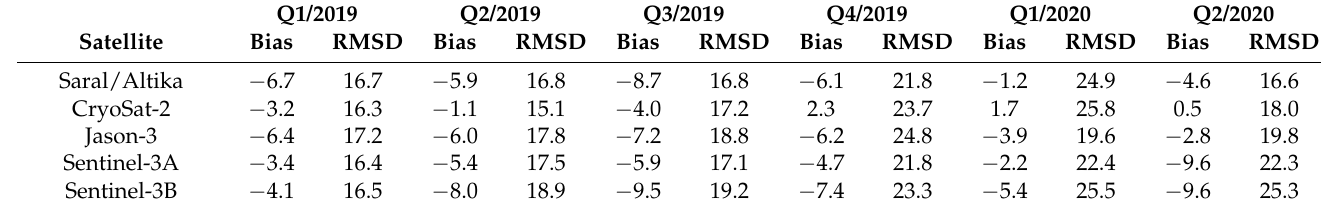
Figure 13. Left : distribution of BS-WAV NRT SWH on 30 December 2019 (17:00 UTC) and a Jason- 3 satellite track also on 30 December 2019 (16:53:13–16:54:56 UTC). Right : distribution of SWH on 18 December 2018 (22:00 UTC) and a Jason-3 satellite track on 18 December 2018 (21:49:15–21:50:58 UTC).